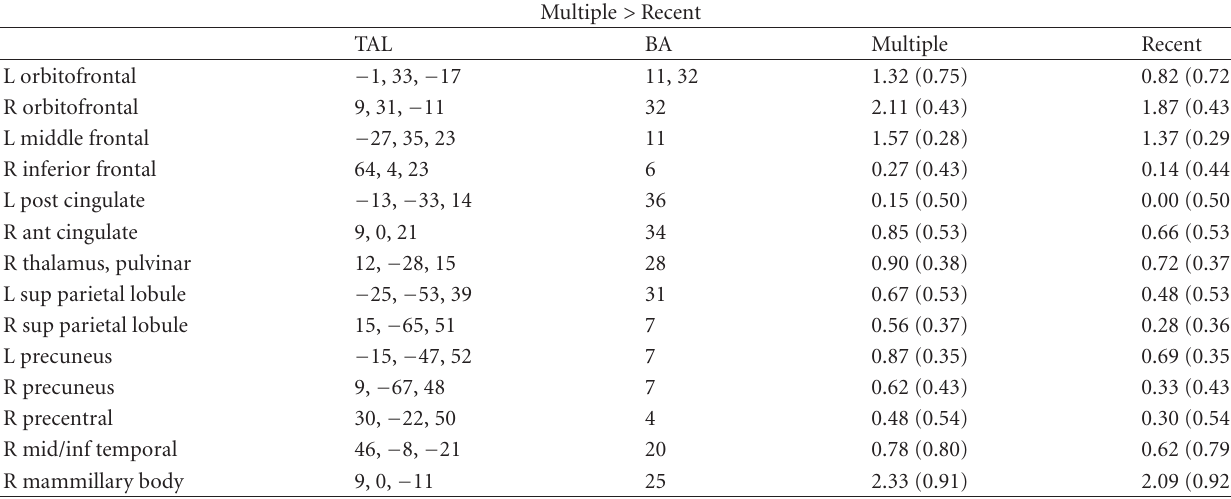
Table 4: Mean e ff ect sizes (standard error of the mean) for the multiple and recent retrieval conditions compared to REST at P < .01. Clusters were taken from the direct comparison of multiple > recent retrieval. Noted are Talairach coordinates (TAL) and Brodmann’s areas (BA) referencing the center of the activation cluster (posterior, post; anterior, ant; superior, sup; middle, mid; inferior,